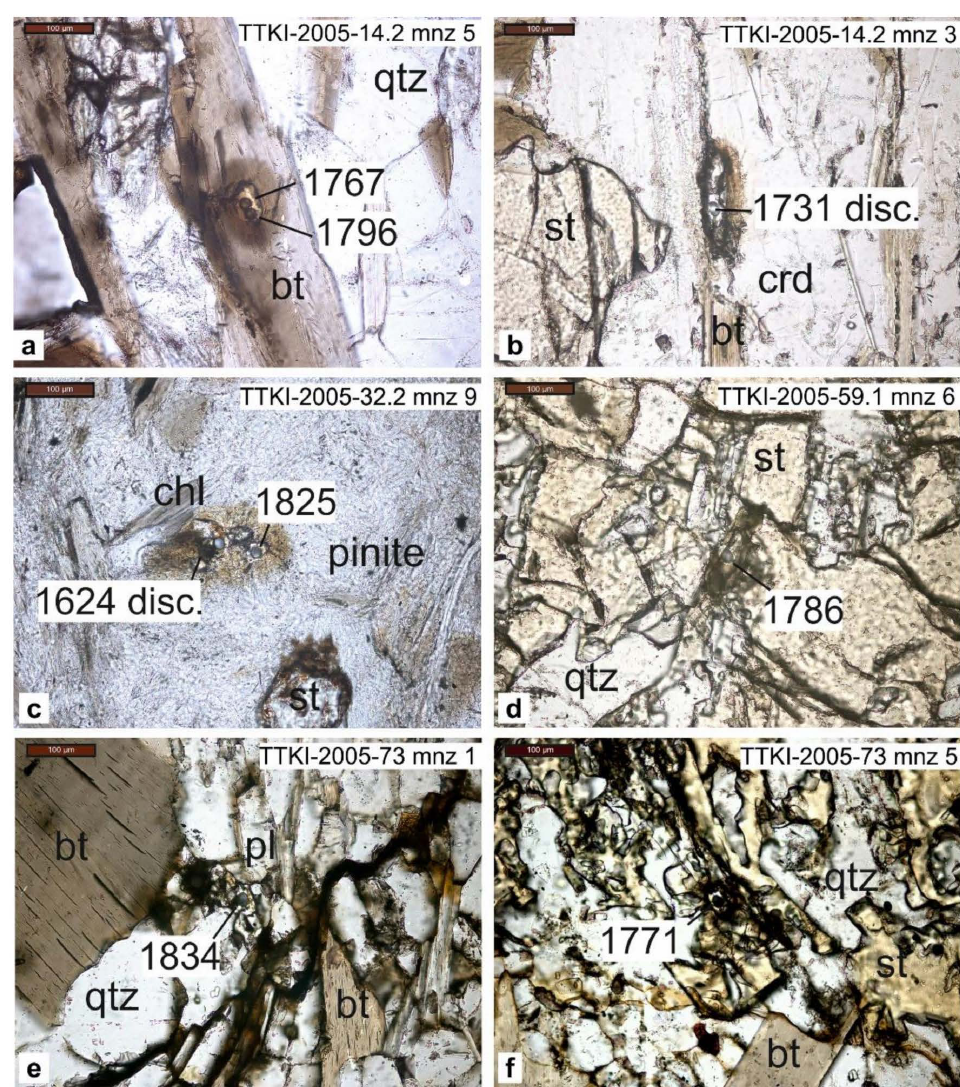
Figure 11. Microphotographs (parallel nicols) of the dated monazite grains showing the 207 Pb / 206 Pb ages (Ma) for each spot (Supplementary Materials, Table S6). The 2 σ error in each age is ± 20 Ma. The scale bar in the upper left corner of each figure is 100 µ m. ( a ) TTKI-2005-14.2, mnz6a and mnz6b; ( b ) TTKI-2005-14.2, mnz3; ( c ) TTKI-2005-32.2, mnz9; ( d ) TTKI-2005-59.1, mnz6; ( e ) TTKI-2005-73, mnz1; ( f ) TTKI-2005-73,